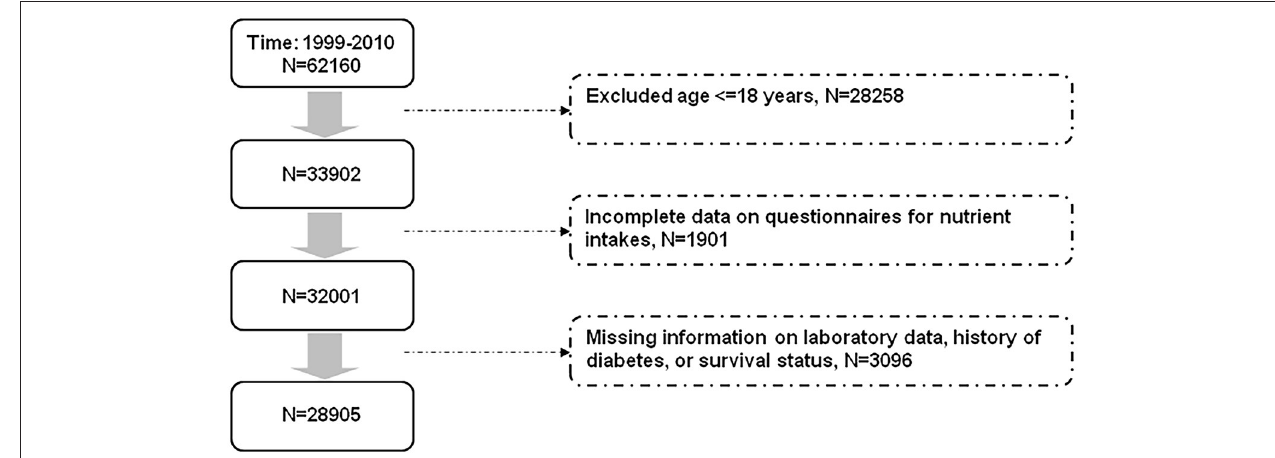
FIGURE 1 | Flow diagram displaying the selection of study participants for